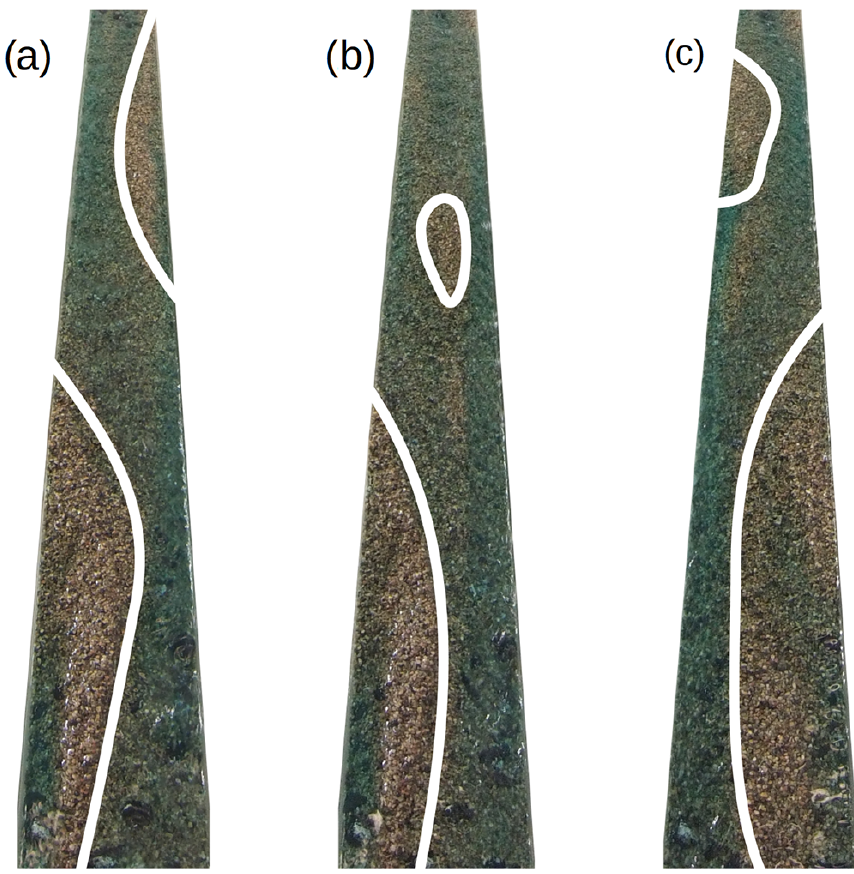
Figure 10. Three frames taken from the beginning, middle and end of a thalweg sweep event from the left side of the flume to the right and resulting in a switching of the thalweg position, in experiment 200H using GSD narrow . These frames correspond to approximately 28 to 30s of the accompanying